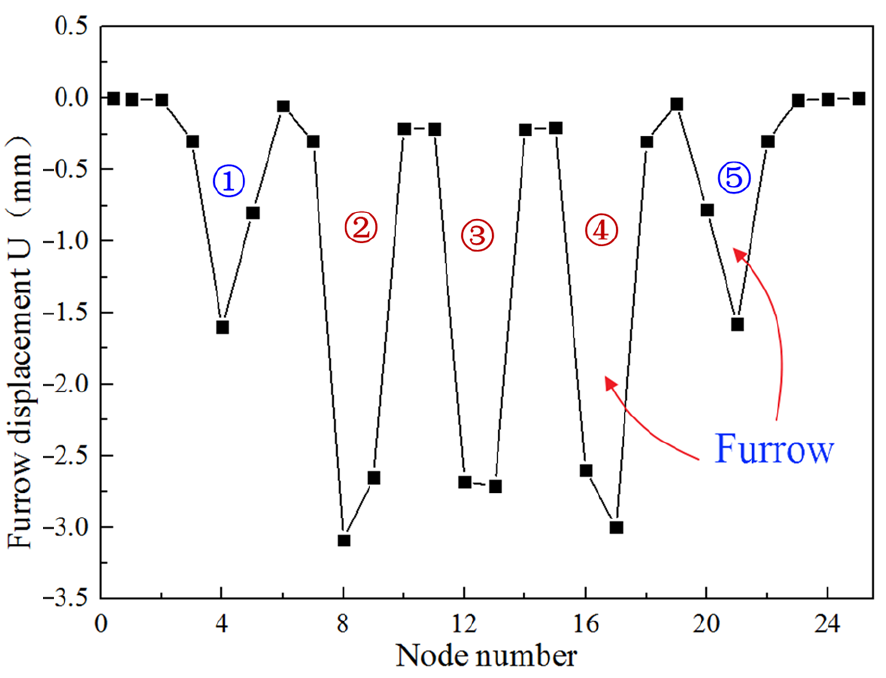
Figure 8. Furrow section displacement of whole tooth.